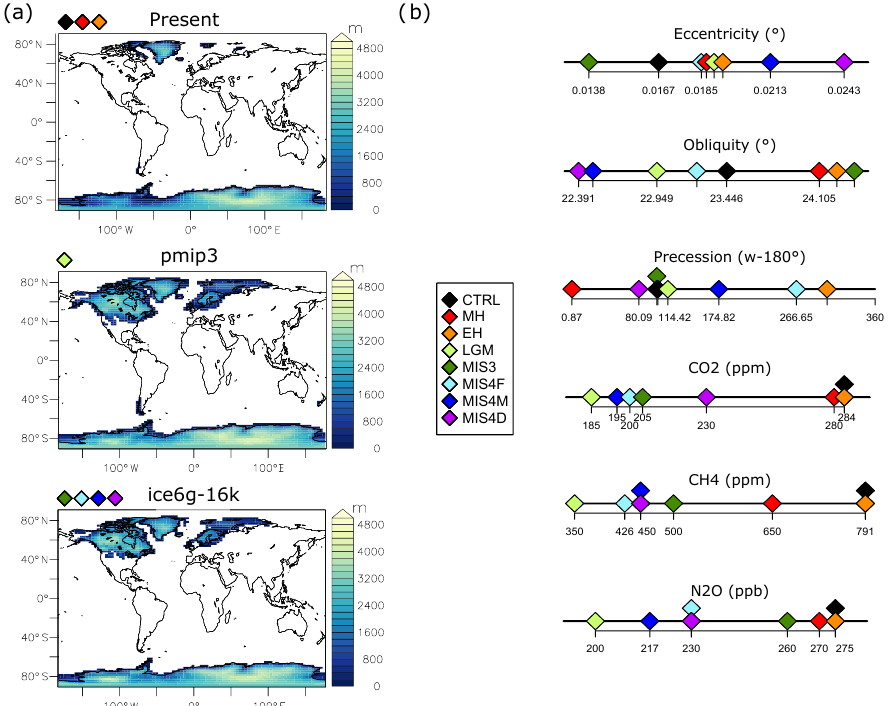
Figure 1. (a) The three ice sheet covers used as boundary conditions. The 0k ice sheet is used in the CTRL, MH and EH simulations. The pmip3 ice sheet (Abe-Ouchi et al., 2015) is used in the LGM simulation. The ICE6g-16k ice sheet (Peltier et al., 2015) is used in the MIS3 and all the MIS4 (F, M and D) simulations and (b) the different values of the other forcing parameters for all the